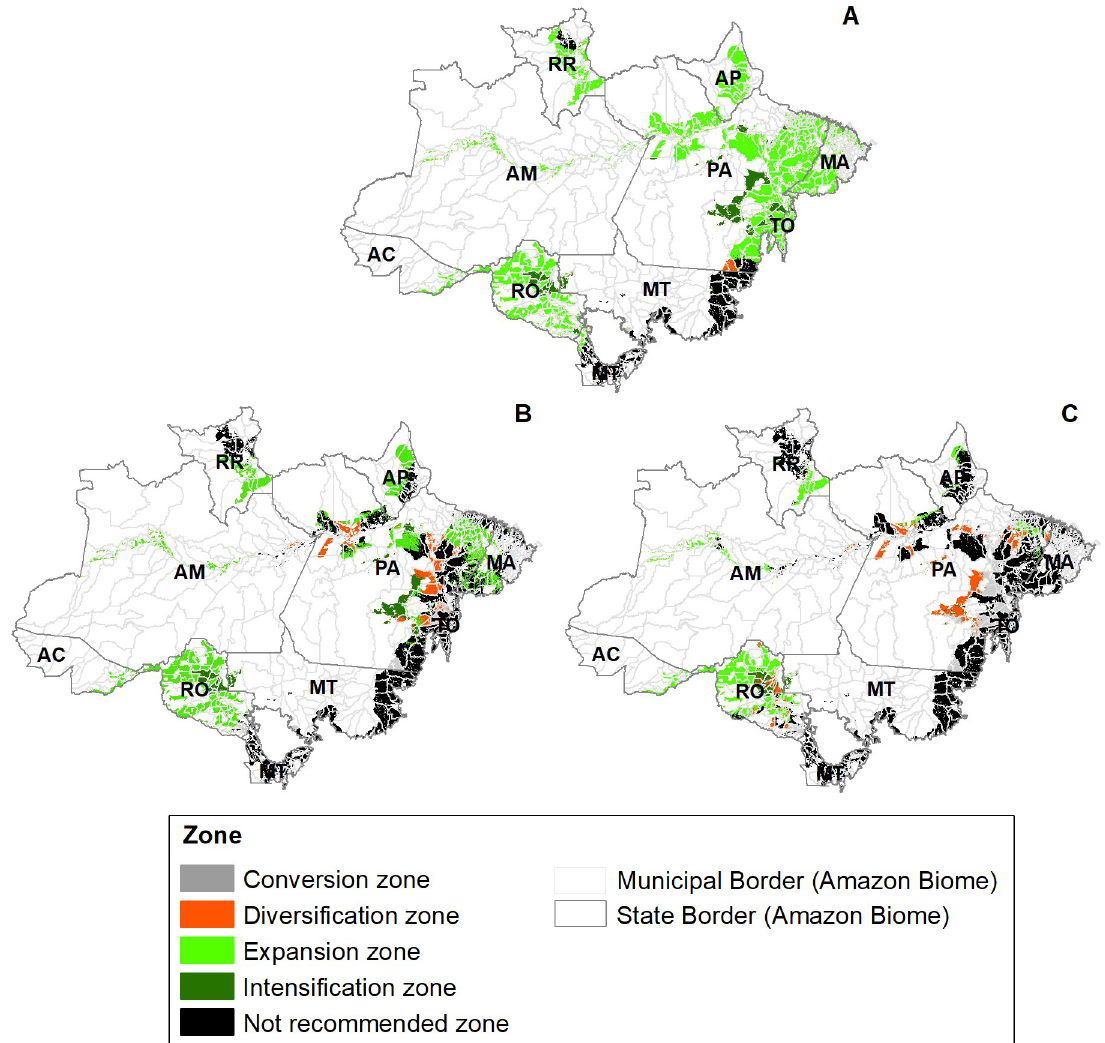
Fig 4. Zoning of climate change adaptation for planting cocoa in the Brazilian Amazon biome (AC–Acre, AP-Amapa´, AM– Amazonas, MA—Maranh ã o, MT—Mato Grosso, PA–Para´, RO–Rondoˆnia,—RR–Roraima and TO–Tocantins). (A) Current, (B) 2050 (RCP4.5), and (C) 2050 (RCP8.5). Map source: Municipal border and state border [48].